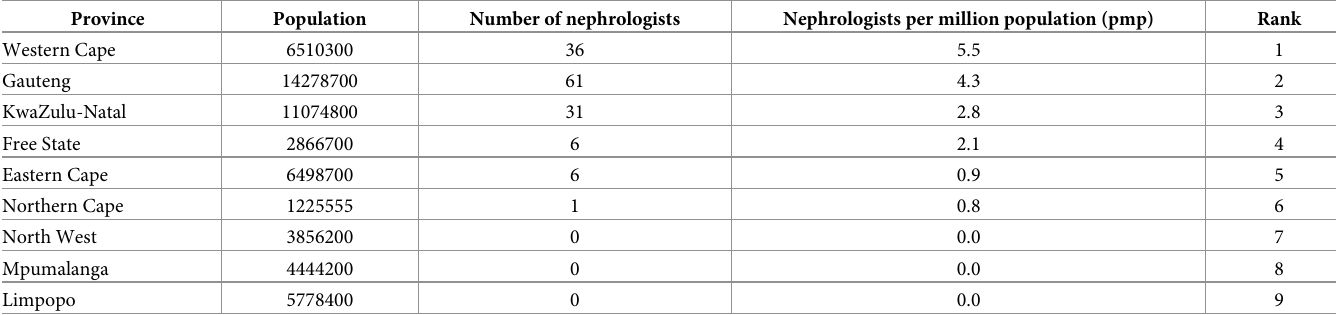
Table 3. Density of nephrologists per million population, by province, in